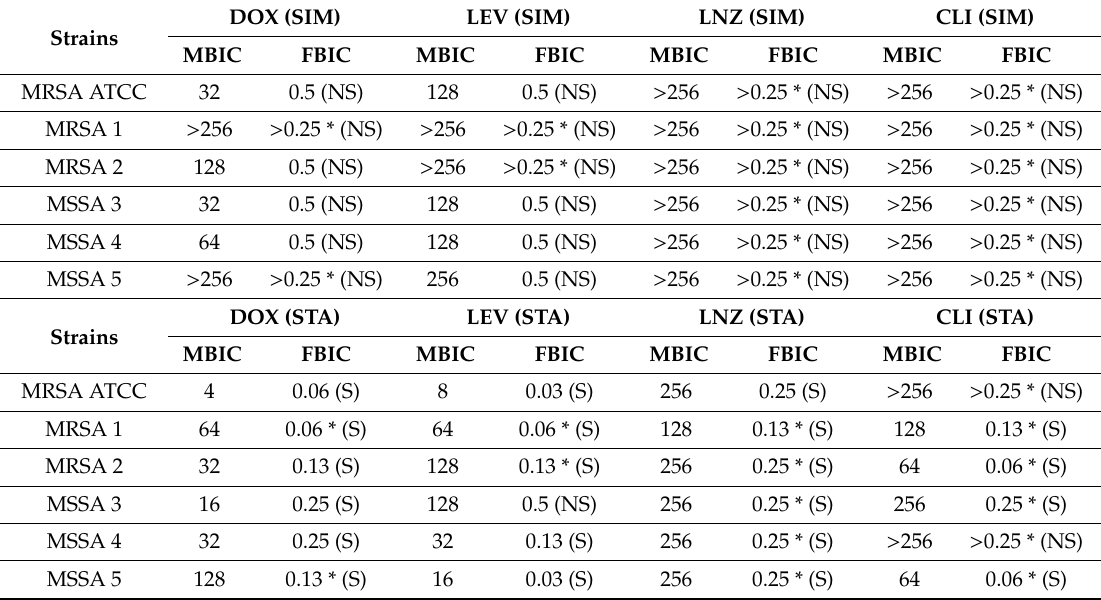
Table 2. Synergistic inhibitory e ff ects of simultaneous (SIM) and staggered (STA) exposure of phage–antibiotic